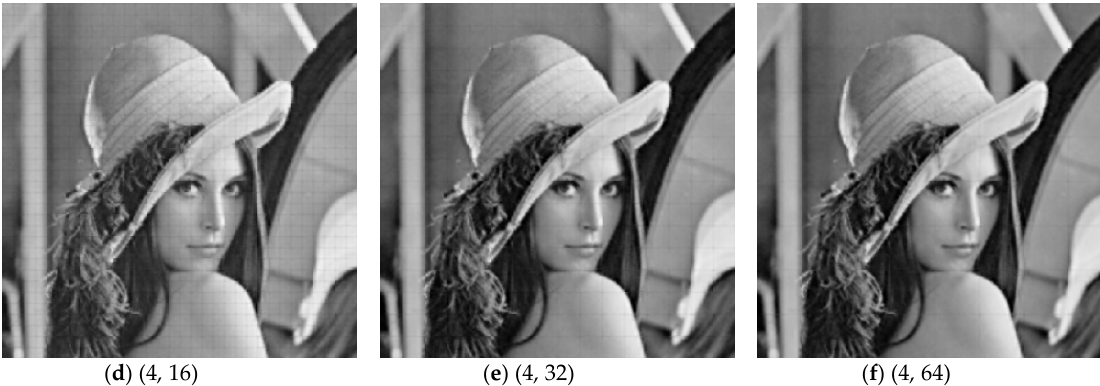
Figure 7. Visual quality comparison on test image Lenna for LA structures with various block-size pairs when the subrate is 0.1.